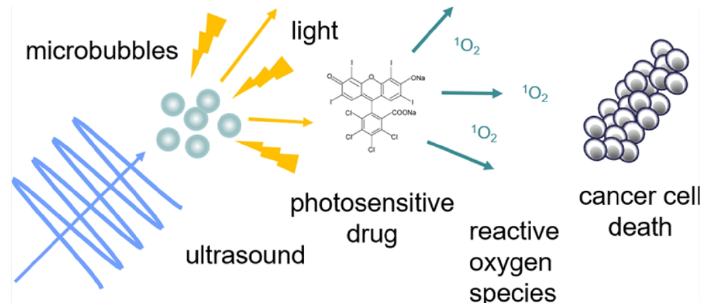
Figure 4. Sketch of the operation of a sonoluminescence-activated photosensitive drug. Note that the use of ultrasound waves enables employing this approach both for diagnostic and therapeutic applications, thereby increasing the range of applications of photosensitive drugs, which is currently restricted by a limited penetration of light in the biological tissues and bodily fluids.